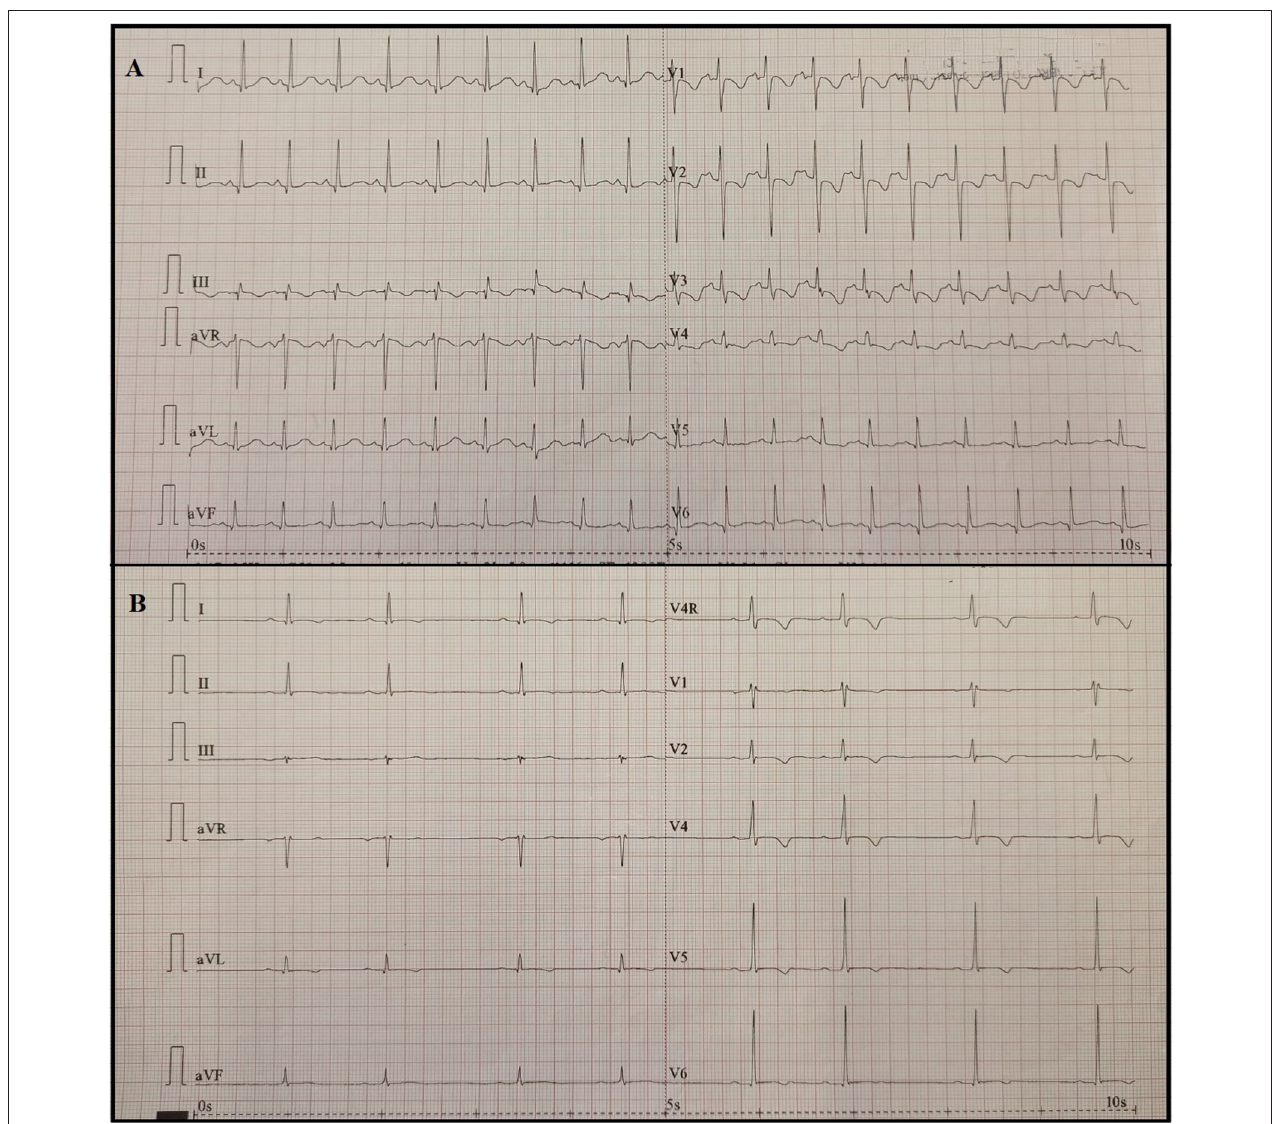
FIGURE 4 | (A) 12-lead ECG of the first patient 5 days after fever onset showed a mild ST-segment depression and a deeper T-wave inversion compared with previous ECG in the anterior precordial leads; (B) 12-lead ECG of the second patient 8 days after fever onset showed a sinus bradycardia (HR 48 beats per minute) with a first-degree atrioventricular block (PR =